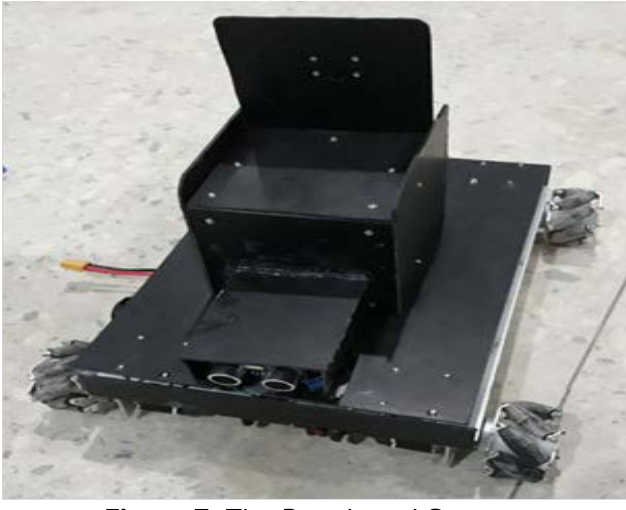
Figure 7. The Developed